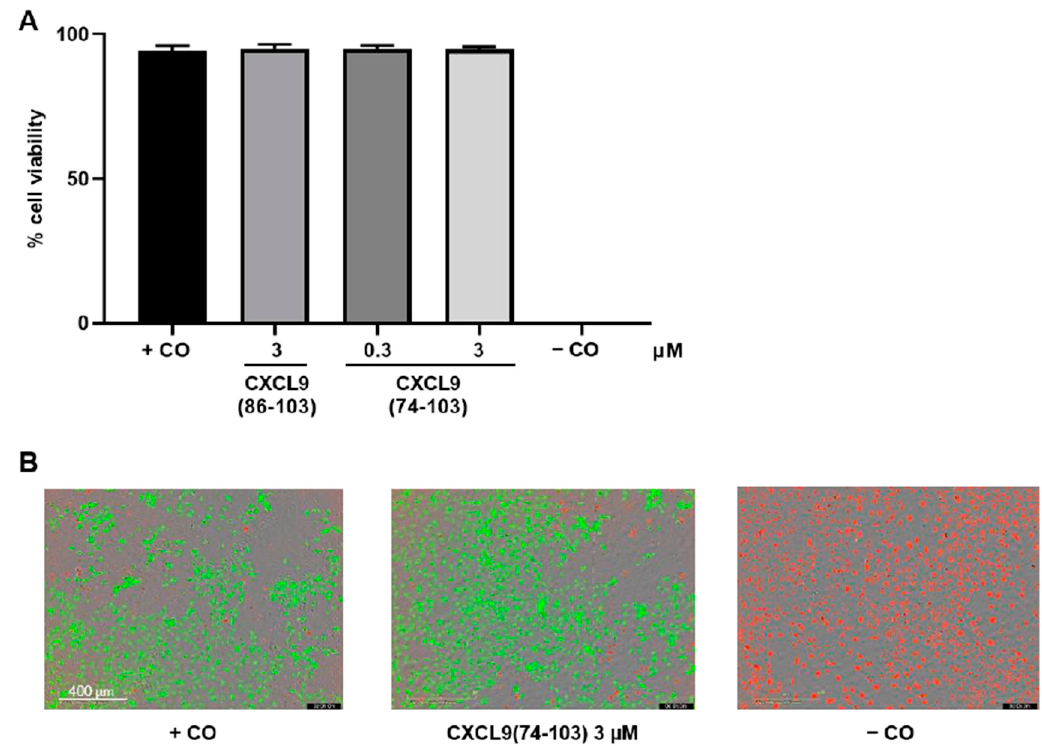
Figure 5. CXCL9-derived peptides are not toxic to primary endothelial cells. HMVECs were treated with CXCL9-derived peptides (0, 0.3 or 3 µ M). ( A ) After 24 h, the toxicity was assessed using the LIVE/DEAD viability/cytotoxicity assay. The fluorescence was measured using the IncuCyte S3 live cell imaging system. Viable cells were stained with calcein-AM (green) and dead cells with ethidium homodimer-1 (red). Positive control (+CO) cells were untreated. Negative control ( − CO) cells were incubated with 2% ( v / v ) Triton X-100 to induce cell death. The mean ( ± SEM) percentage of cell viability is depicted ( n = 4). ( B ) Representative images of positive and negative control cells and cells treated with 3 µ M CXCL9(74-103) are shown. Scale bar = 400 µ